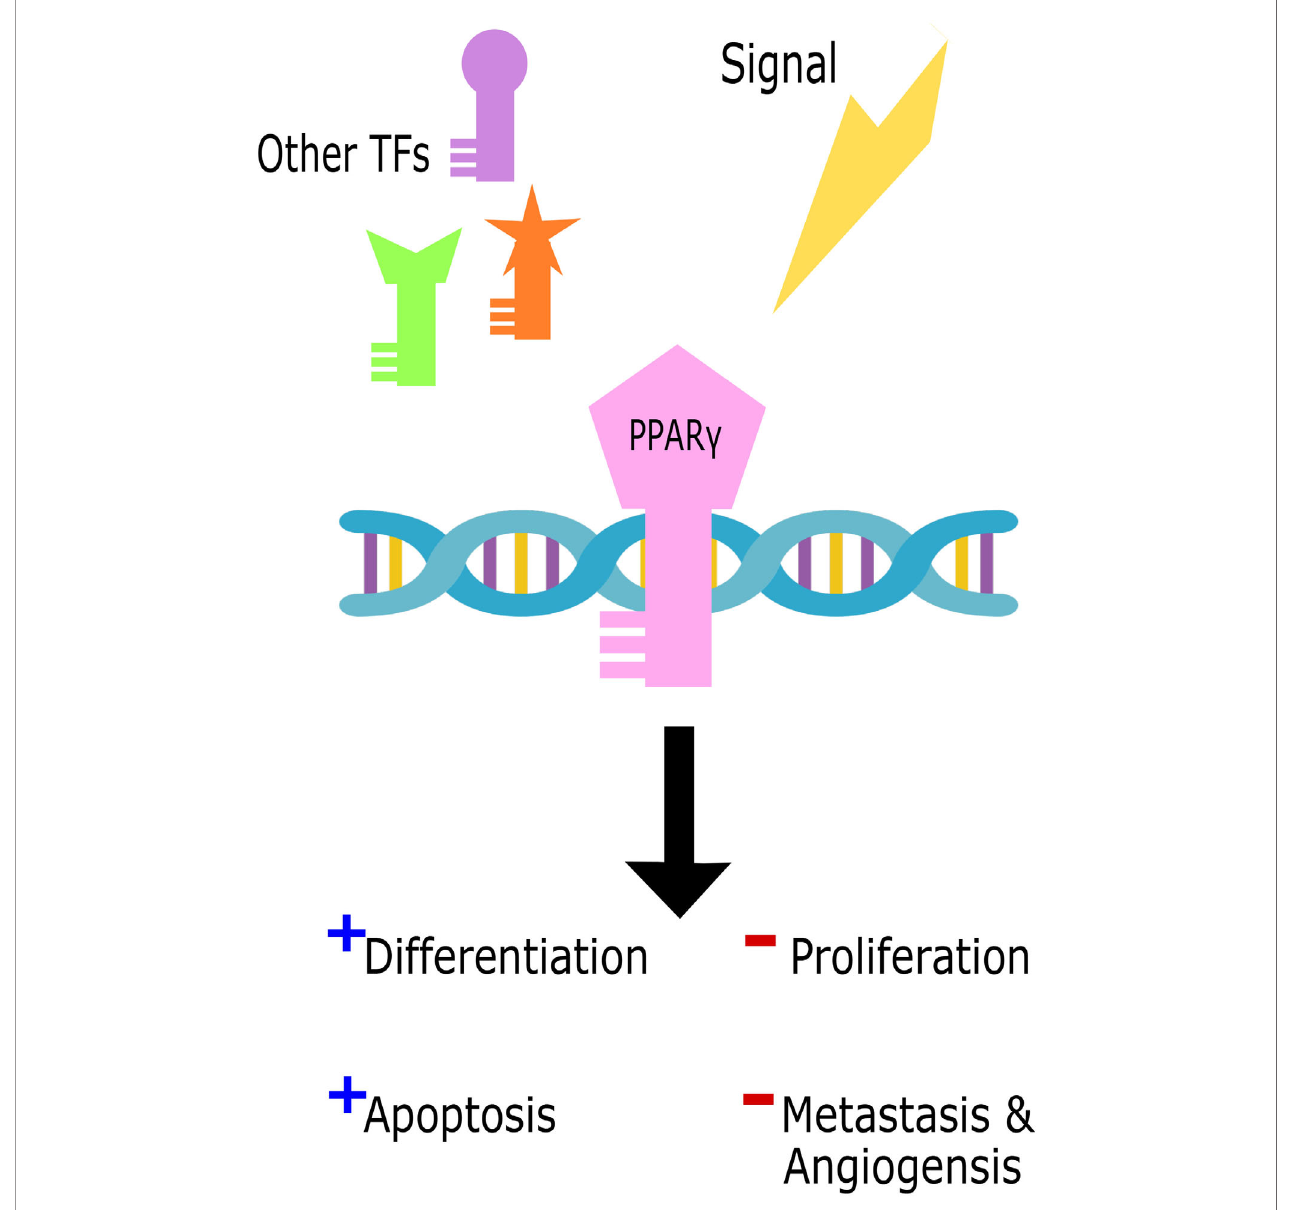
FIGURE 4 | The dual role of Ppar g in the cell. Cell signals in parallel with other transcription factors (TFs) trigger Ppar g binding to DNA to initiate either tumor suppressive promoting